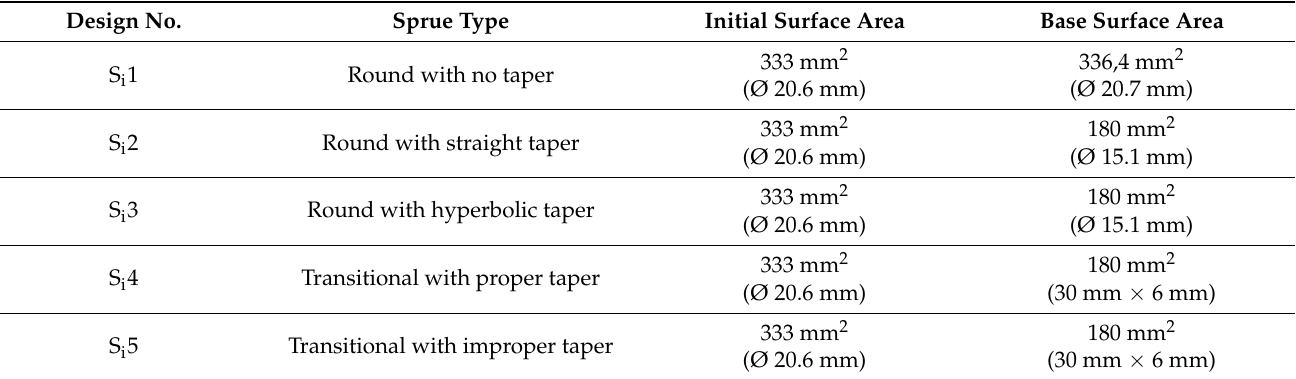
Table 1. Sprue designs analyzed in initial